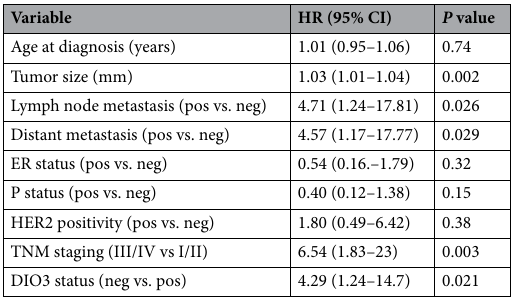
Table 2. Univariate Cox regression analysis of overall survival in breast cancer patients in the primary cohort. HR hazard ratio, CI confidence interval, ER estrogen receptor, P progesterone, HER2 human epidermal growth factor